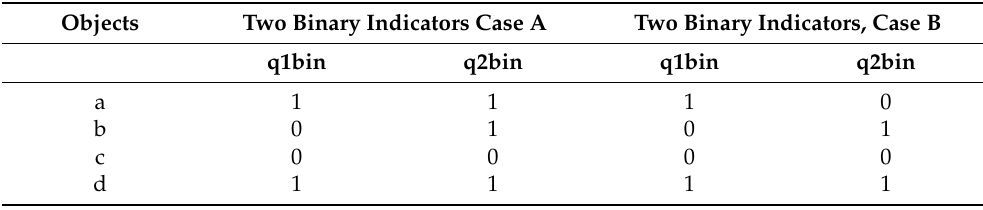
Table 7. A fictitious